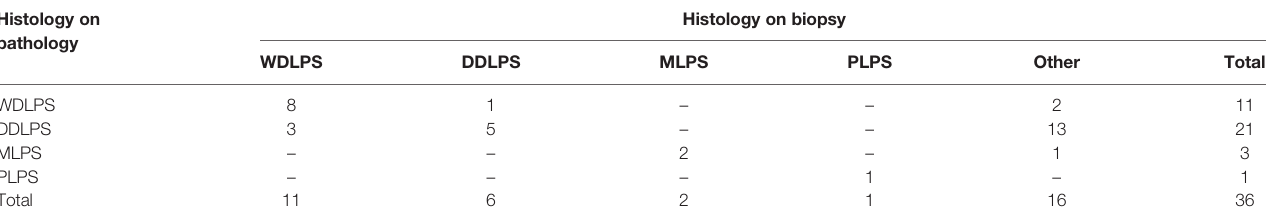
TABLE 2 | Comparison of histology between biopsy and